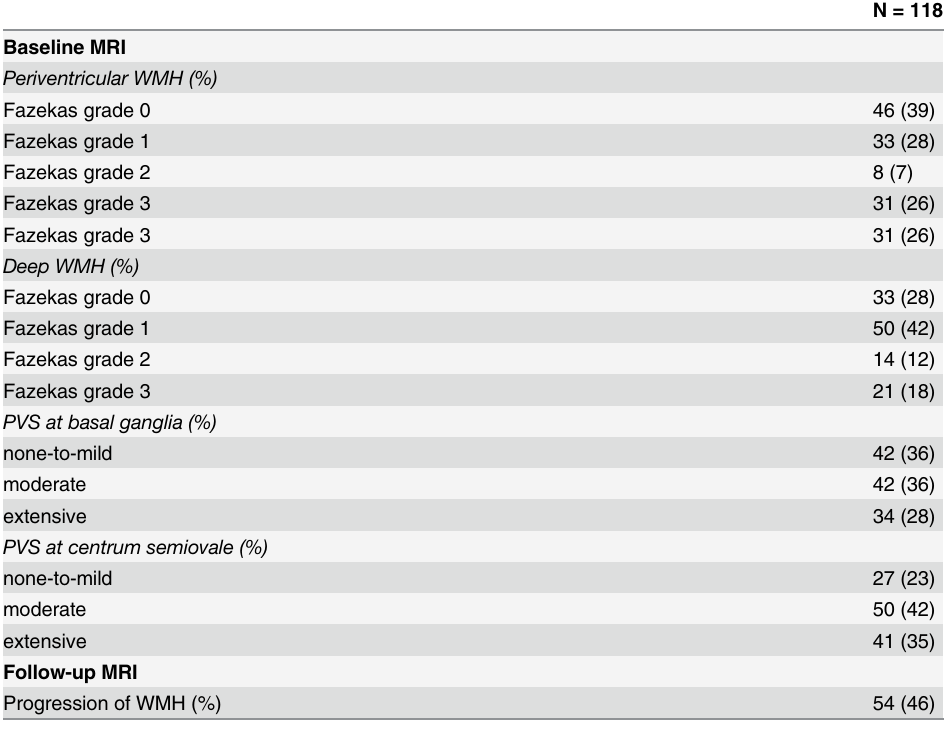
Table 2. MRI characteristics. Baseline MRI Periventricular WMH